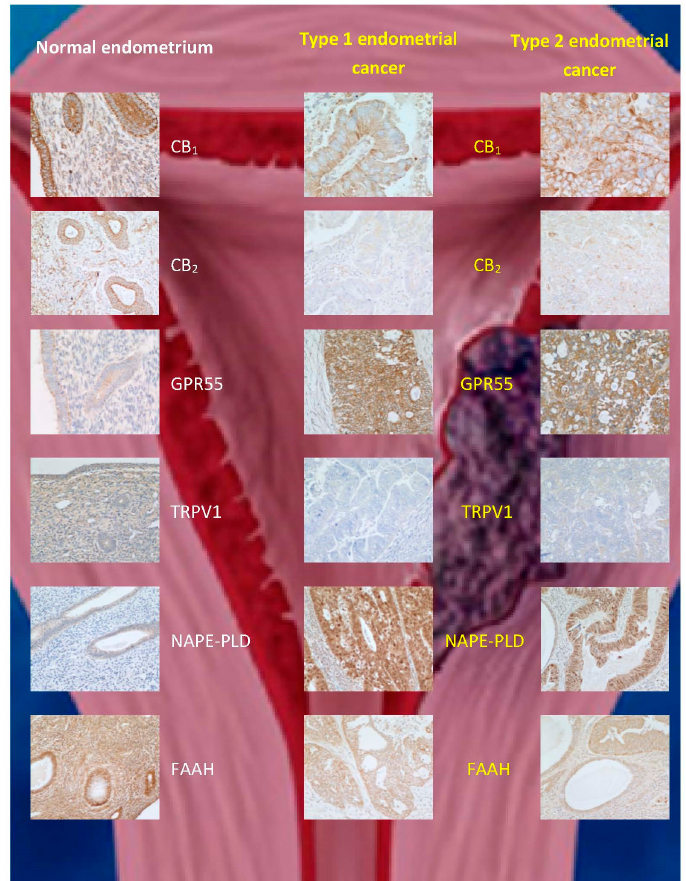
Figure 3. Immunohistochemical staining patterns for ECS proteins in normal endometrium and (type 1 and type 2) endometrial cancer. The data are taken from [74], where validation for the commercial antibodies and techniques used can be found. Note the reduction in CB1, CB2, TRPV1, and FAAH protein staining and increases for GPR55 and N -acylphosphatidylethanolamine-specific phospholipase D (NAPE-PLD) expression in both types of endometrial cancer when compared to that of normal